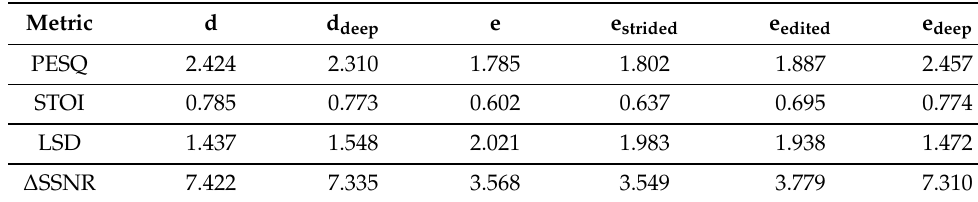
Table 8. Effect of Denoising Autoencoder (DAE) related hyperparameters: increasing the depth d deep and e deep ; the use of strided convolutions, e strided ; and, the use of one-dimensional (1D) strided convolutions with PReLU e edited